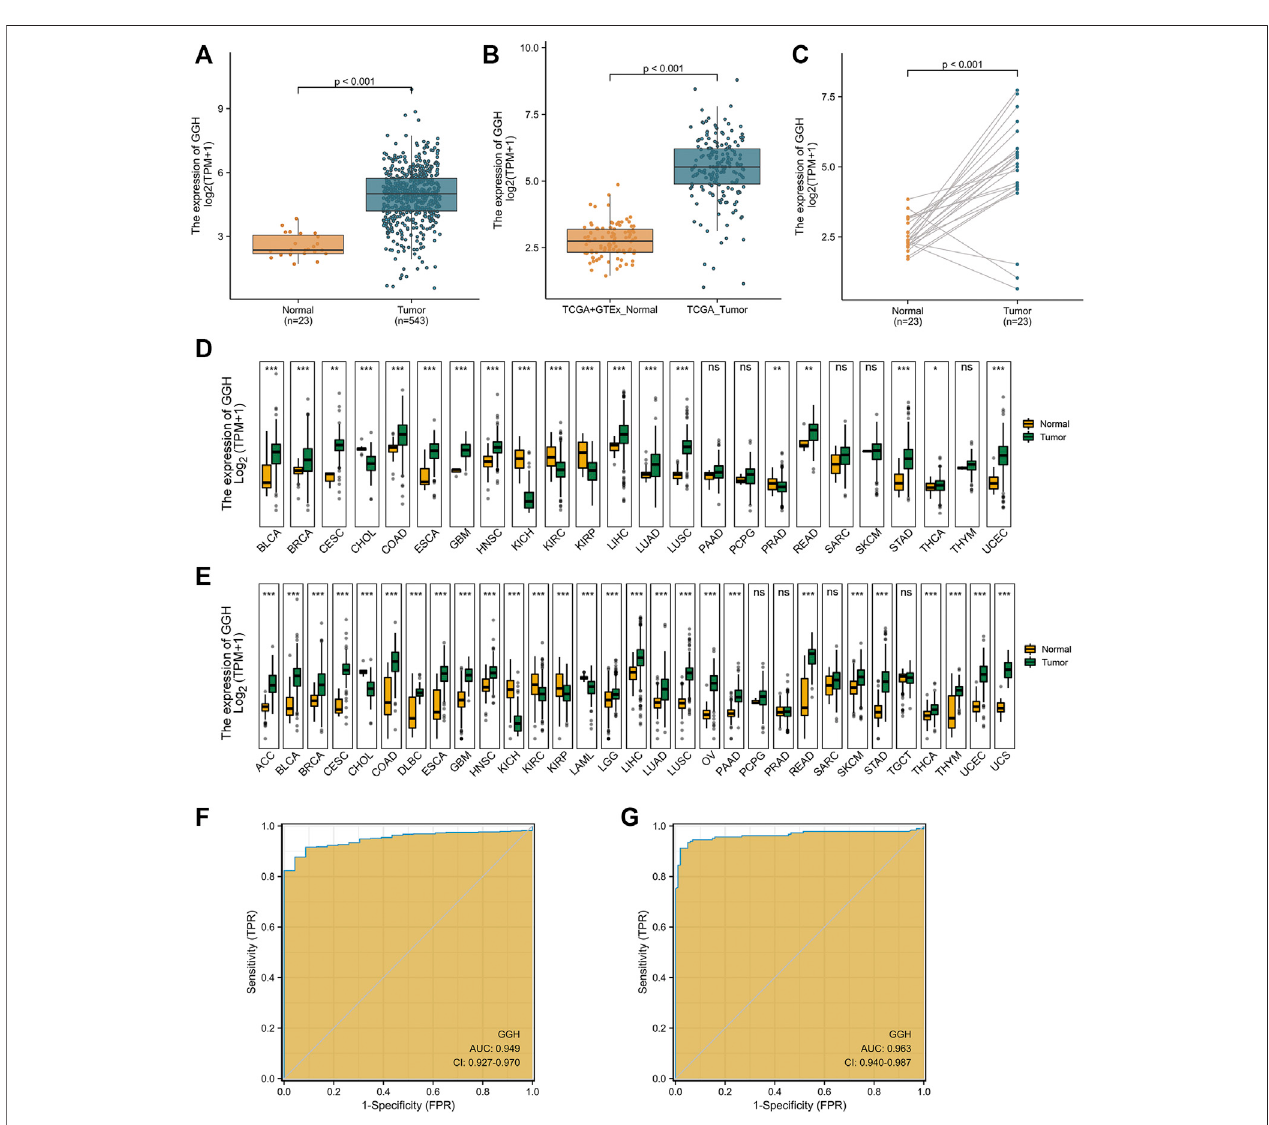
FIGURE 2 | Elevated GGH mRNA expression in UCEC. (A) Elevated GGH mRNA in UCEC tumor samples compared to adjacent normal samples from TCGA. (B) Elevated GGH in UCEC tumor samples and normal samples from combined TCGA and GTEx datasets. (C) Differences in GGH mRNA expression between individual UCEC tumor samples and paired adjacent normal tissue samples from TCGA. (D) Differences in GGH mRNA expression between tumor tissues and paracancerous samples for 33 cancer types from TCGA. (E) Differences in GGH mRNA expression between tumor tissues and normal samples for 33 cancer types from the combined TCGA and GTEx dataset; ns: p ≥ 0.05; *: p < 0.05; **: p < 0.01; ***: p < 0.001. (F,G) ROC curve assessing the ef fi ciency of GGH mRNA expression for distinguishingUCECtumortissuesfromnontumortissuesfromthecombinedTCGAandGTExdataset(AUC (cid:1) 0.949)andTCGAonly(AUC (cid:1) 0.963).Theabscissaisthe False Positive Rate and the ordinate is the True Positive